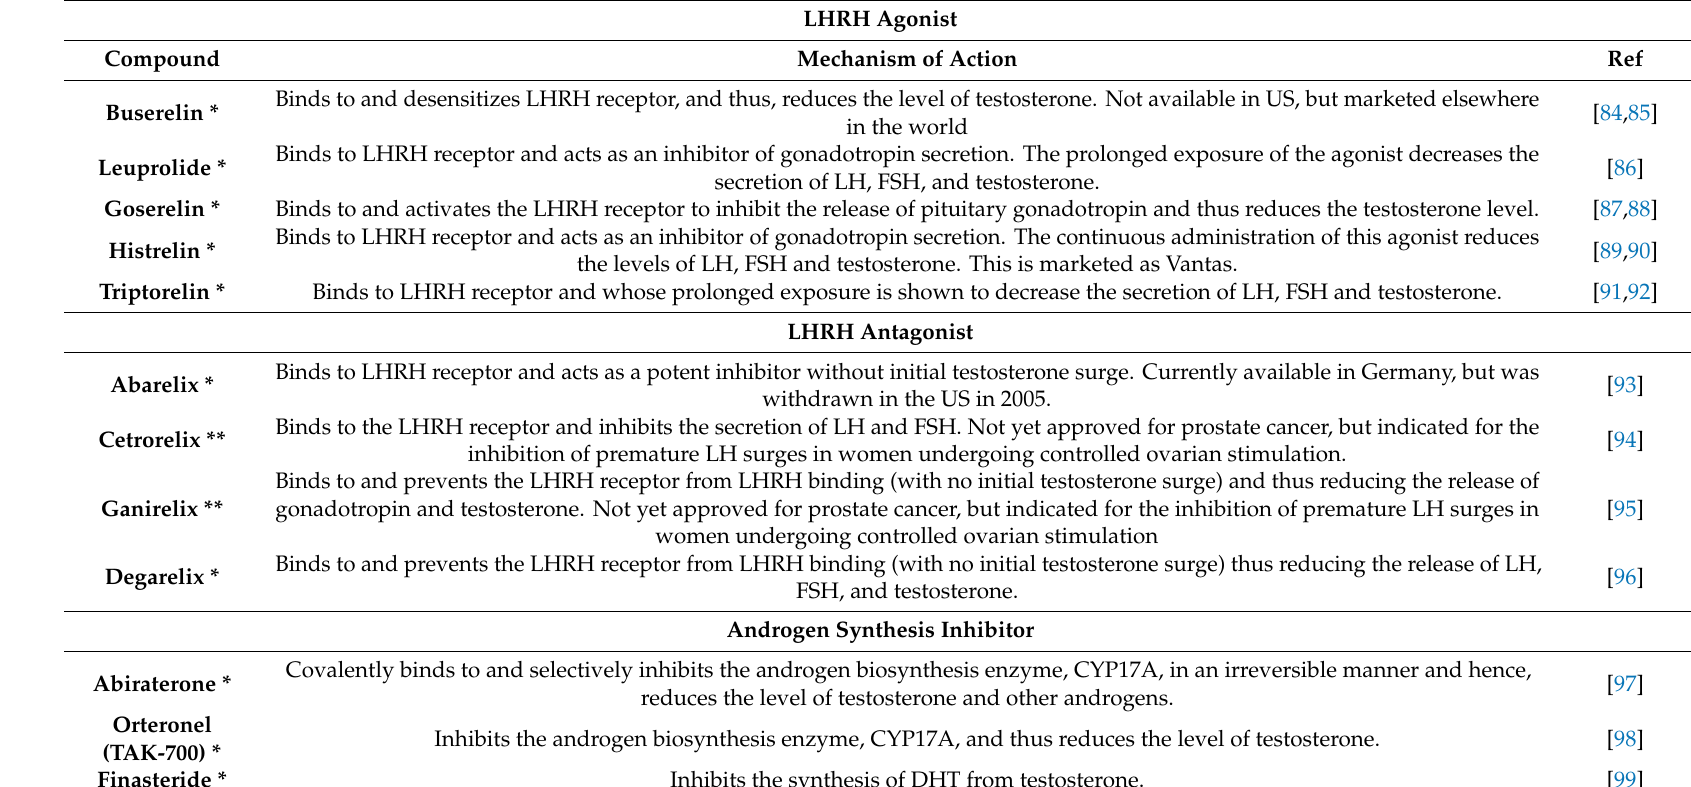
Table 1. List of compounds targeting the androgen synthesis directly or indirectly and their mechanisms of action (* compounds that are / were in clinical practice, ** compounds that show promise in preclinical studies, but have not yet been evaluated in clinical trials or have yet brought to clinical